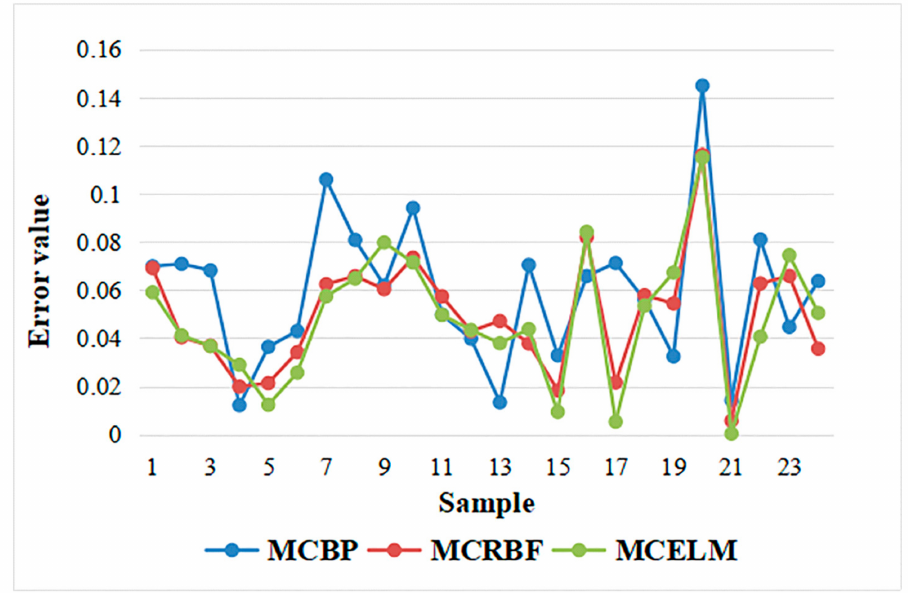
Figure 8. Prediction error comparison of the MCBP, the MCRBF, and the MCELM with 5 nodes. Figure 8 shows that the prediction errors of the MCBP, the MCRBF, and the MCELM models are also relatively low, in this case, but are higher than the error when the number of nodes is 10. In order to more clearly describe the errors when the number of hidden layer nodes are 15, 10, and 5, the overall comparison is described in Table